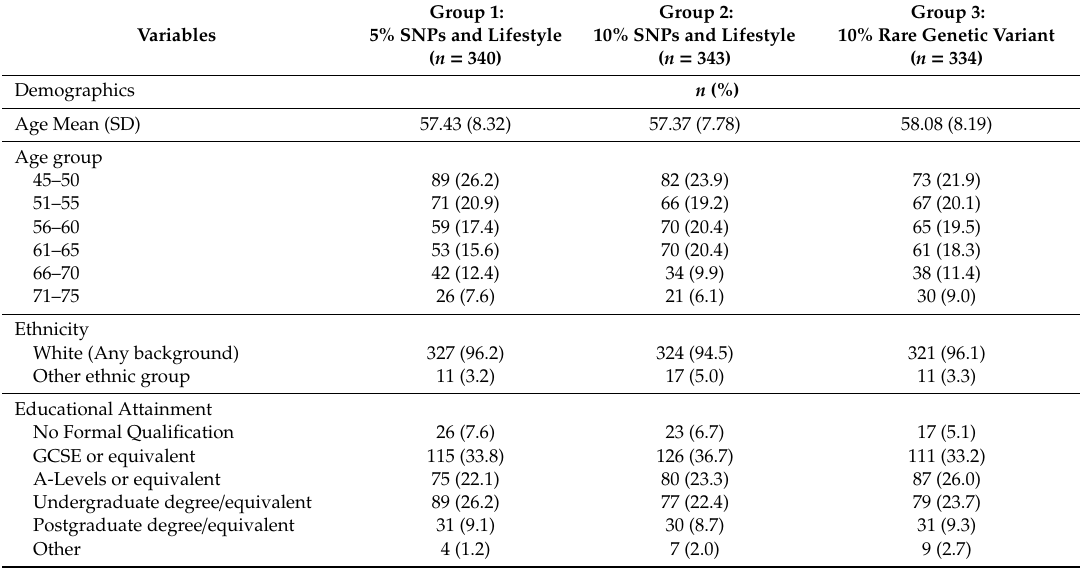
Table 1. Sample characteristics and interest in genetic testing overall and in each randomised experimental group (total n =